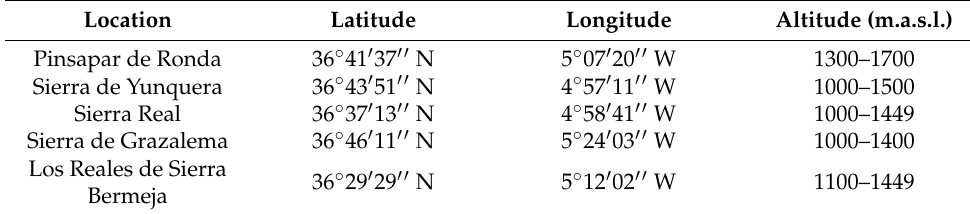
Table 1. Details of the source populations of Abies pinsapo